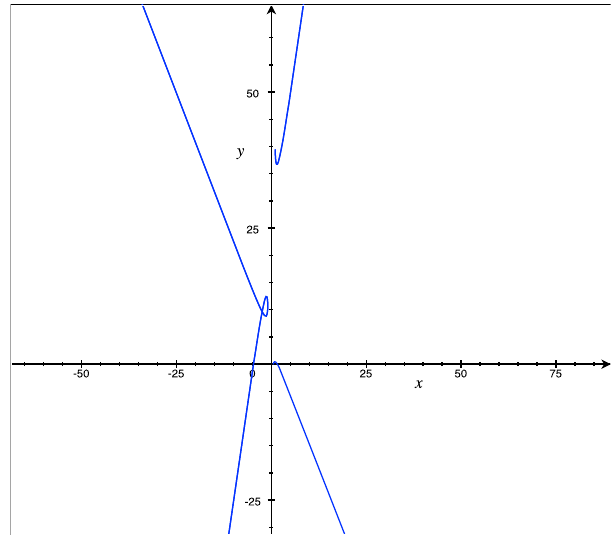
Figure 3: Graph of (cid:5) in the λ μ , ( ) -